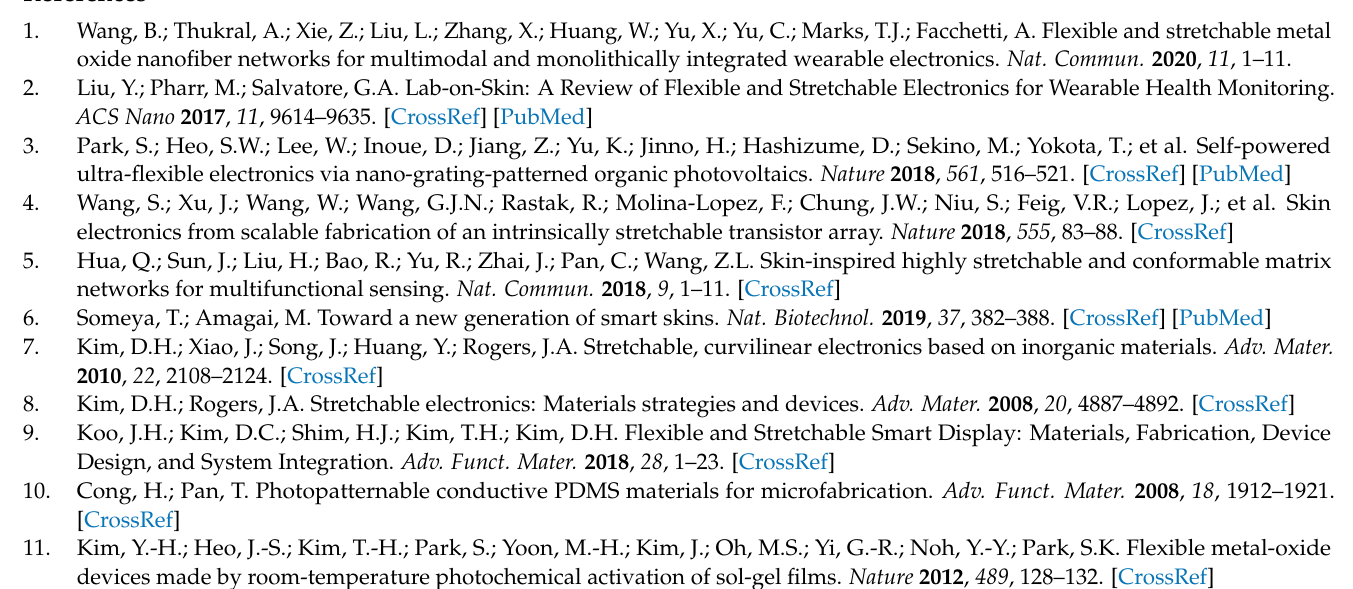
TFTs, Figure S2: The maximum stress induced within a-IGZO TFT devices on reverse-trapezoid substrates with various undercut dimensions, Figure S3: Transfer characteristics and saturation mobility of a -IGZO TFTs on conventional